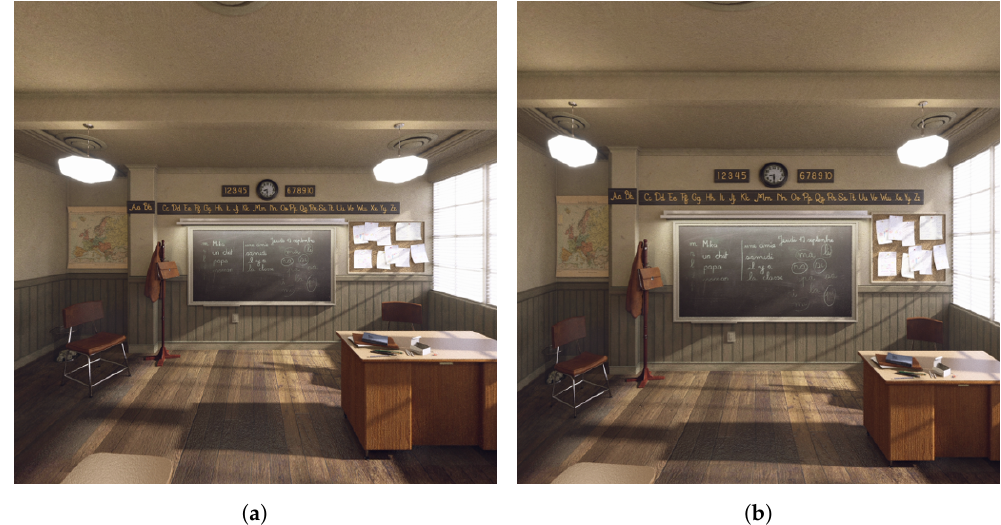
Figure 5. ( a ) Front face of 3 × 2 cubemap projection (CMP); and ( b ) front face of 3 × 2 adjusted cubemap projection